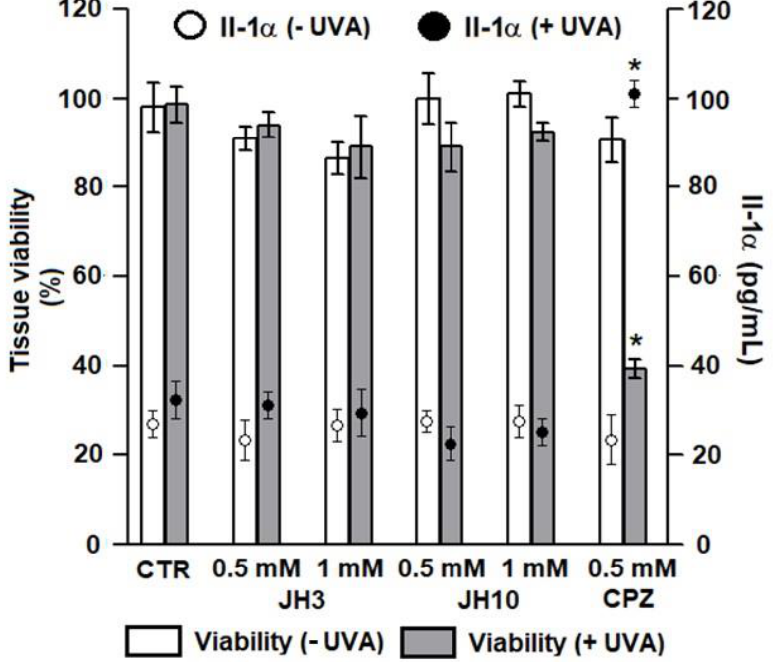
Figure 4. In vitro phototoxic potential of compounds JH3 and JH10 on Episkin TM model. Results are expressed as mean ± standard deviation, samples were tested in two independent experiments using three tissues for each chemical, positive, or negative control. (*) p < 0.05 when compared to non-irradiated epidermis. JH3 and JH10 (final concentrations of 0.5 and 1 mM) solubilized in ethanol (final concentration of 1% in water) were applied topically on the tissue surface; chlorpromazine (CPZ, positive control) final concentration was 0.5 mM, solvent alone served as a negative control (CTR).